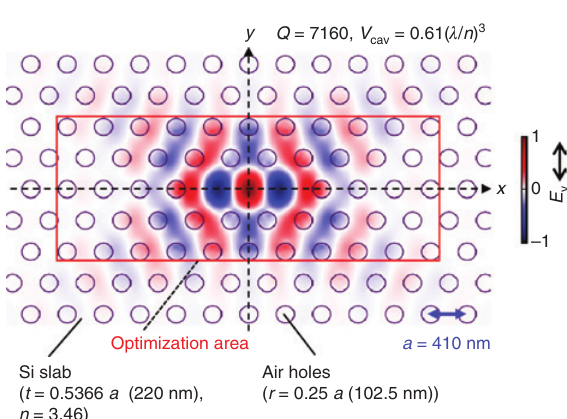
Figure 2: A three-missing-air-holes (L3) cavity is used as the base structure for structural optimization. The lattice constant a is 410 nm. The circles indicate the air holes (hole radius: 102.5 nm = 0.25 a ) formed in Si slab with a refractive index n = 3.46 and a thickness of 220 nm (0.5366 a ). The distribution of the y component of the electric field ( E ) of the y fundamental resonant mode is plotted in color. The theoretical Q factor and modal volume V of the base structure determined by cav FDTD are 7160 and 0.61 ( λ / η ) 3 , respectively. The displacements of the 50 air holes inside the red square are the structural parameters that are used to optimize the cavity design with respect to Q